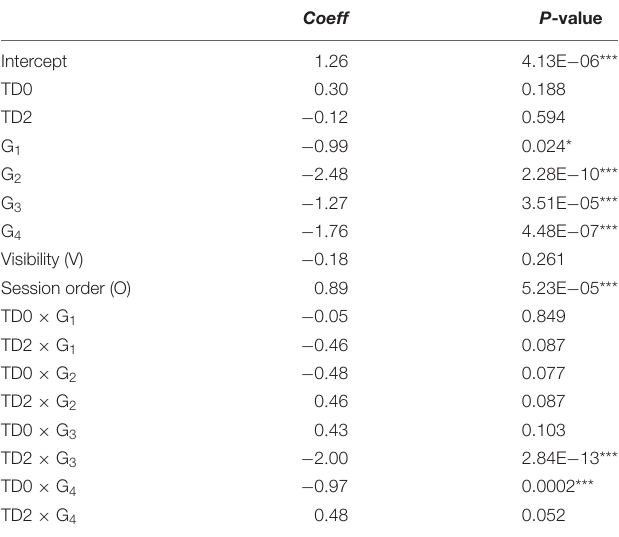
values were lower than the PR of the baseline, see Eq. 2).